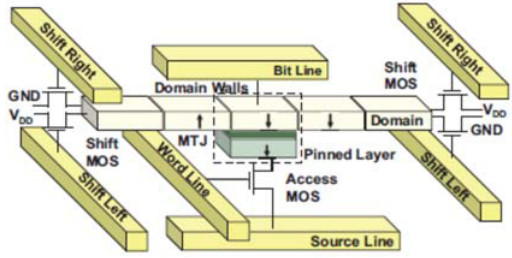
Figure 20. A racetrack domain wall structure.